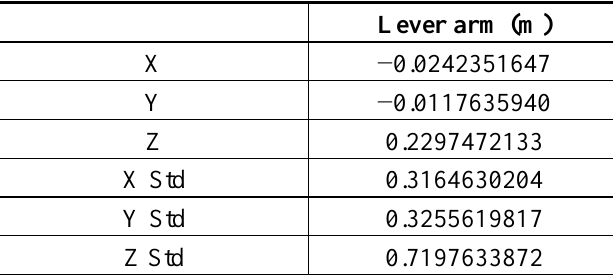
Table 4. Result of lever arm